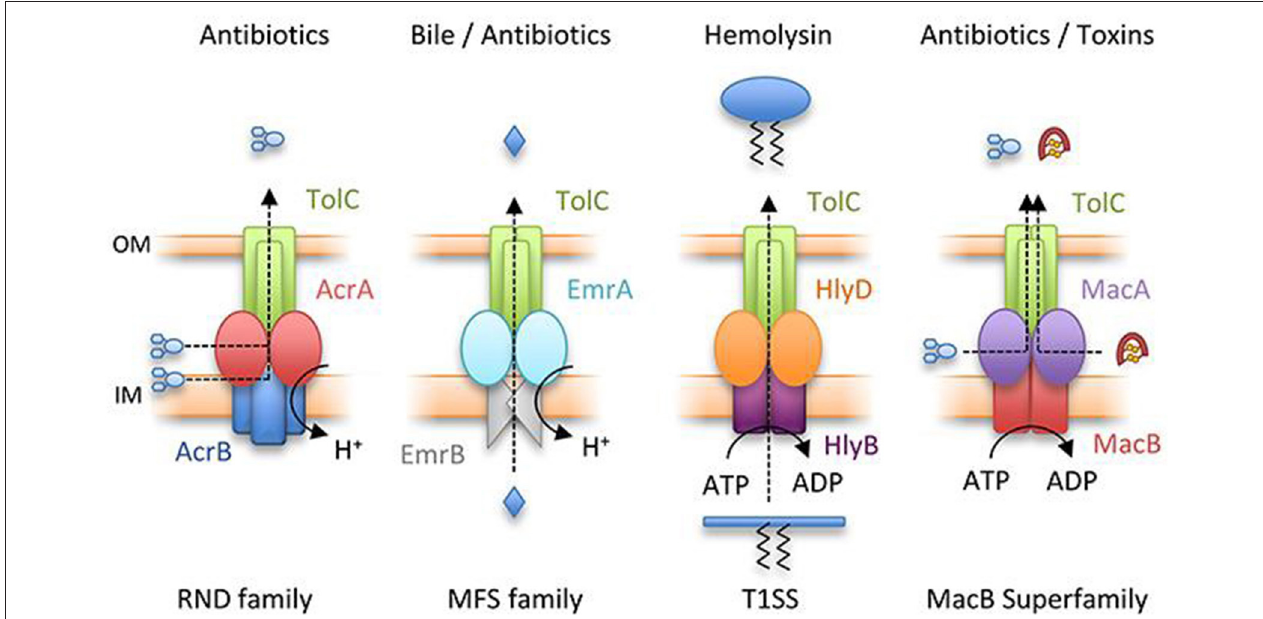
FIGURE 3 | Representation of major classes of tripartite efflux pump. RND family pump, AcrAB-TolC; MFS pump, EmrAB-TolC; T1SS, HlyBD-TolC; MacB superfamily pump, MacAB-TolC. OM and IM represent outer and inner membranes, respectively ( Greene et al., 2018) with permission. MFS, major facilitator superfamily; RND, resistance-nodulation-cell division; T1SS, type I secretion system.